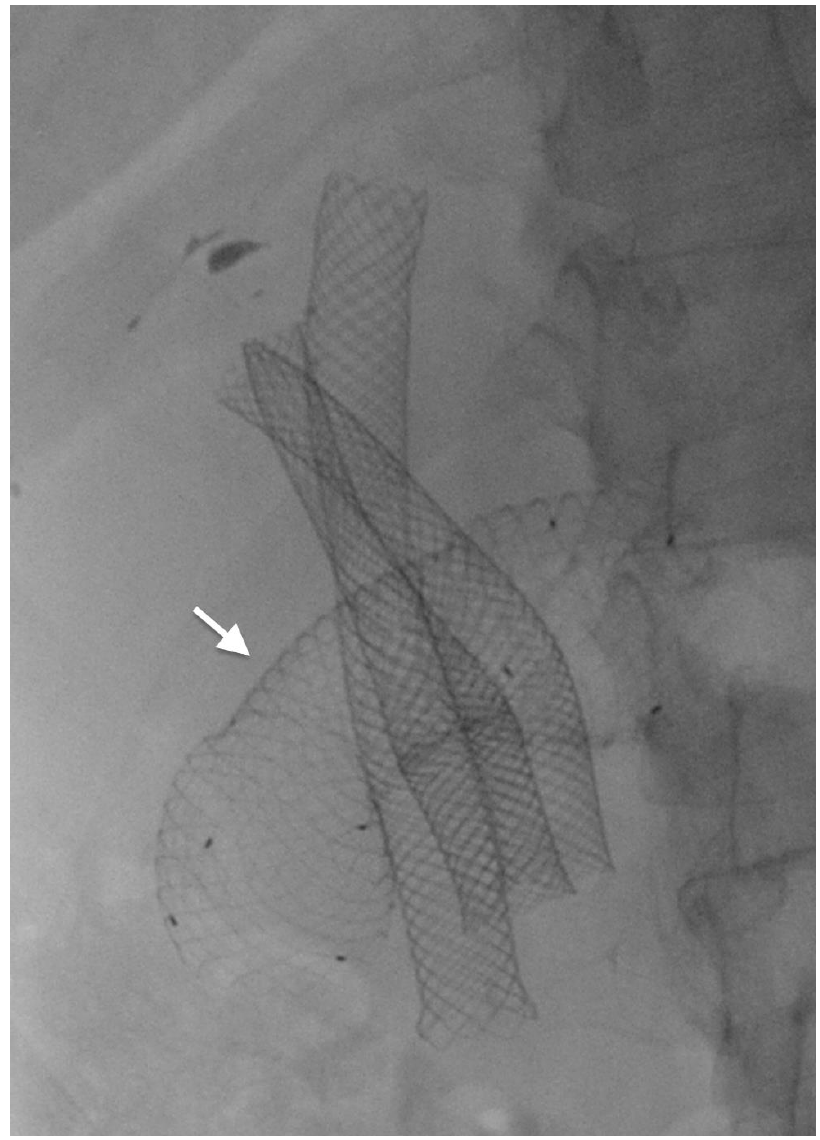
Figure 4. A duodenal uncovered metal stent (arrow) is placed to palliate a duodenal stricture sec- ondary to invasion from gallbladder cancer. Three metal biliary stents were previously placed for jaundice